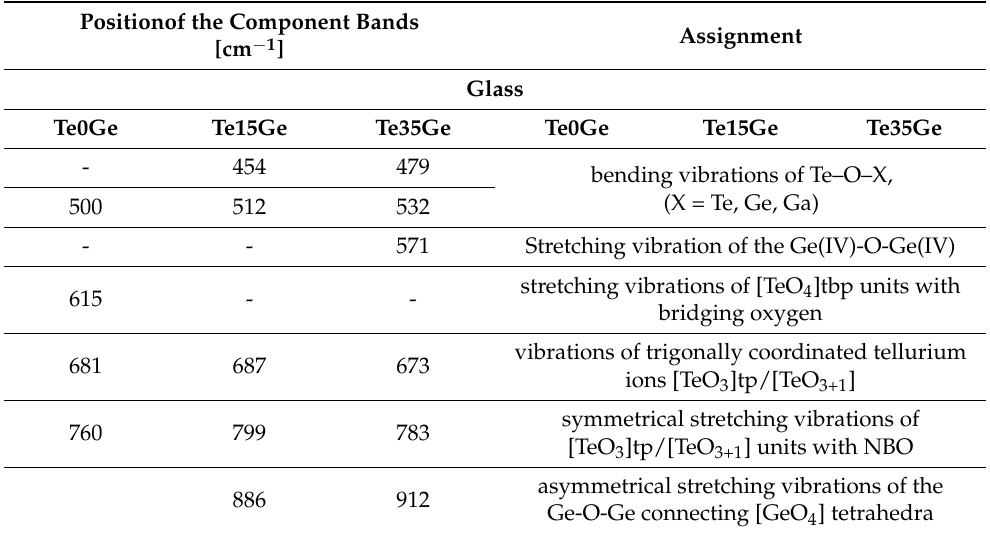
Table 2. Assignment of MIR bands of the Te0Ge, Te15Ge, and Te35Ge glasses doped with Eu 3+ [48,55–58]. Positionof the Component Bands [cm − 1